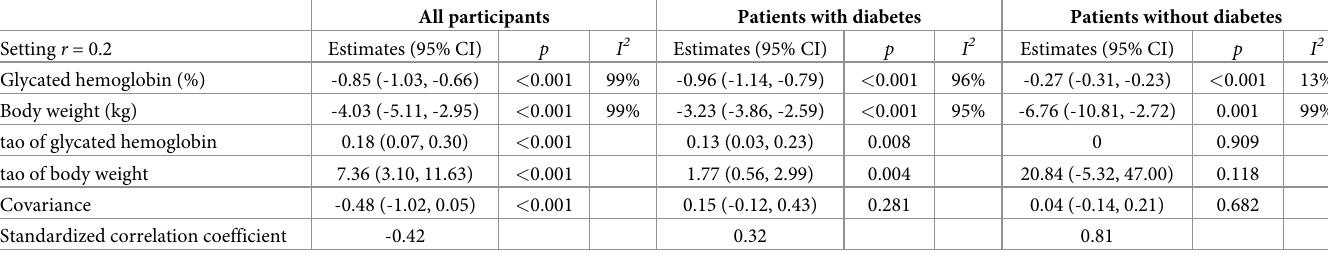
Table 2. The pooled results for glycated hemoglobin level and weight reduction on comparison of glucagon-like peptide-1 receptor agonist and placebo by using the structural equation modeling multivariate meta-analysis according to participant characteristics. All participants Patients with diabetes Patients without diabetes